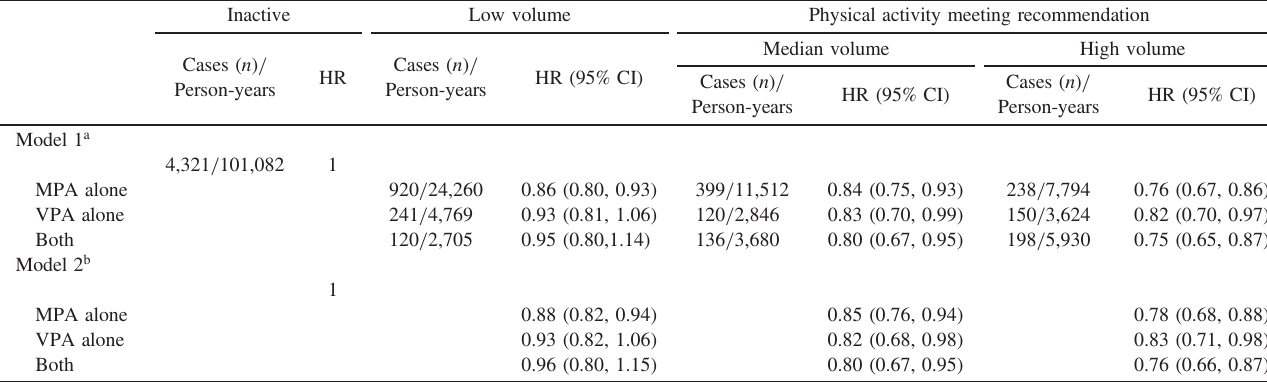
Table 2. Association between risk of depressive symptoms and combinations of leisure-time exercise intensity and volume among 29112 Japanese